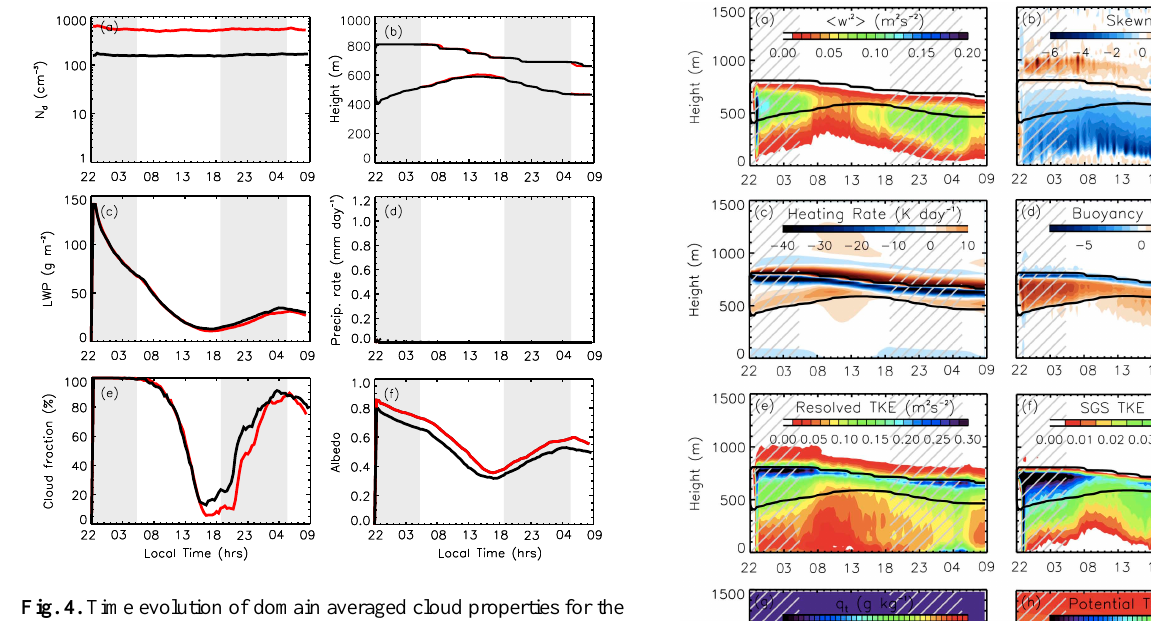
Fig. 4. Time evolution of domain averaged cloud properties for the NP-Ch (red) and NP-Pa (black) cases. Descriptions as Fig. 2.